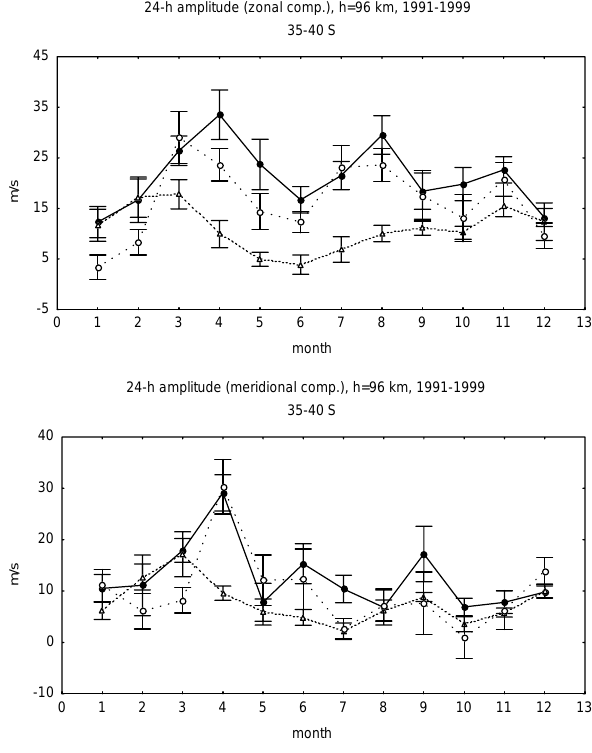
Fig. 8. Same as Fig. 7, except for amplitude of diurnal